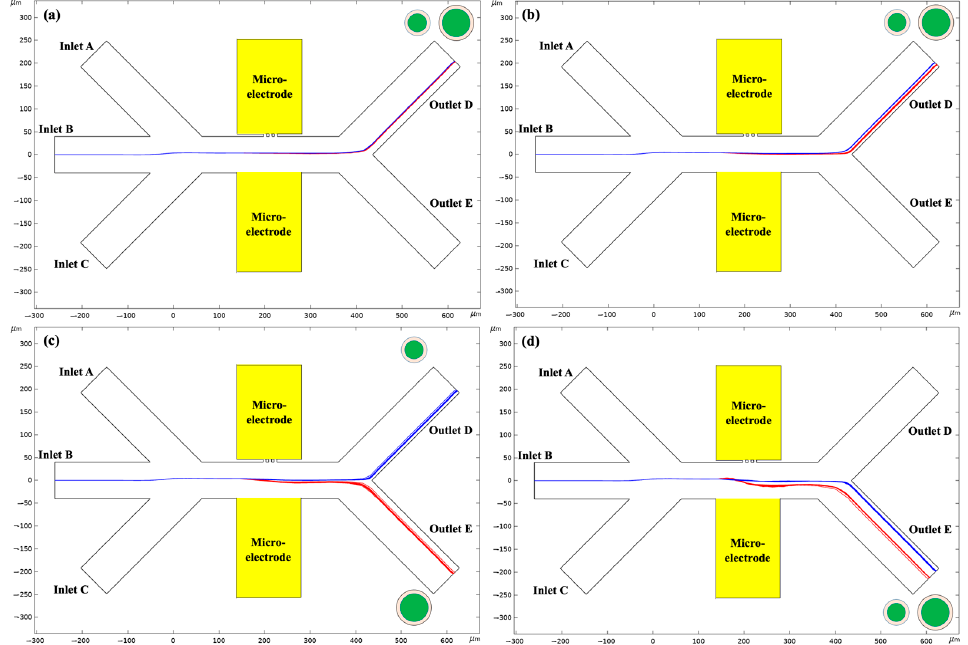
Figure 4. The migration of 3-micrometer and 6-micrometer Chlorella adsorbed and coated with 100% PS particles varying with the applied electric voltage: ( a ) 5 V, ( b ) 15 V, ( c ) 25 V, ( d ) 40 V. The thickness of the coated layer, i.e., the diameter of the PS particles, is 0.6 µ m and the electrical conductivity of the surrounding solution is σ m = 1 × 10 − 7